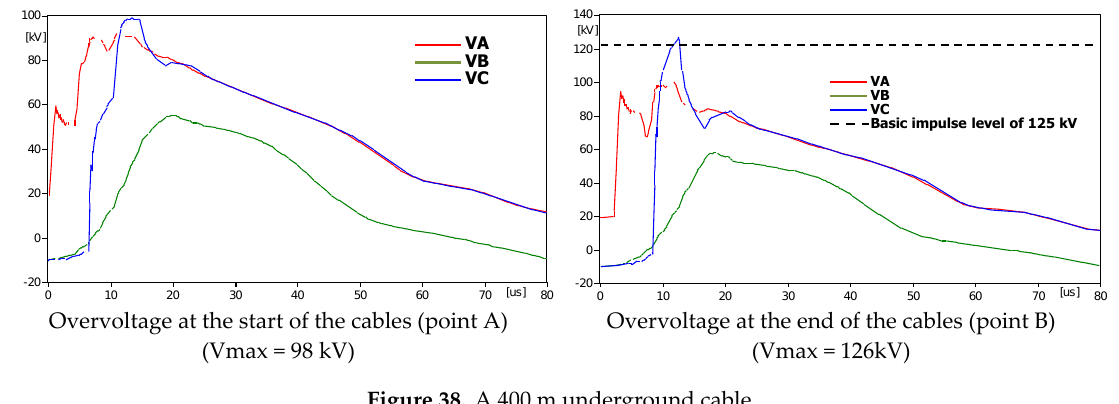
Figure 38. A 400 m underground cable.